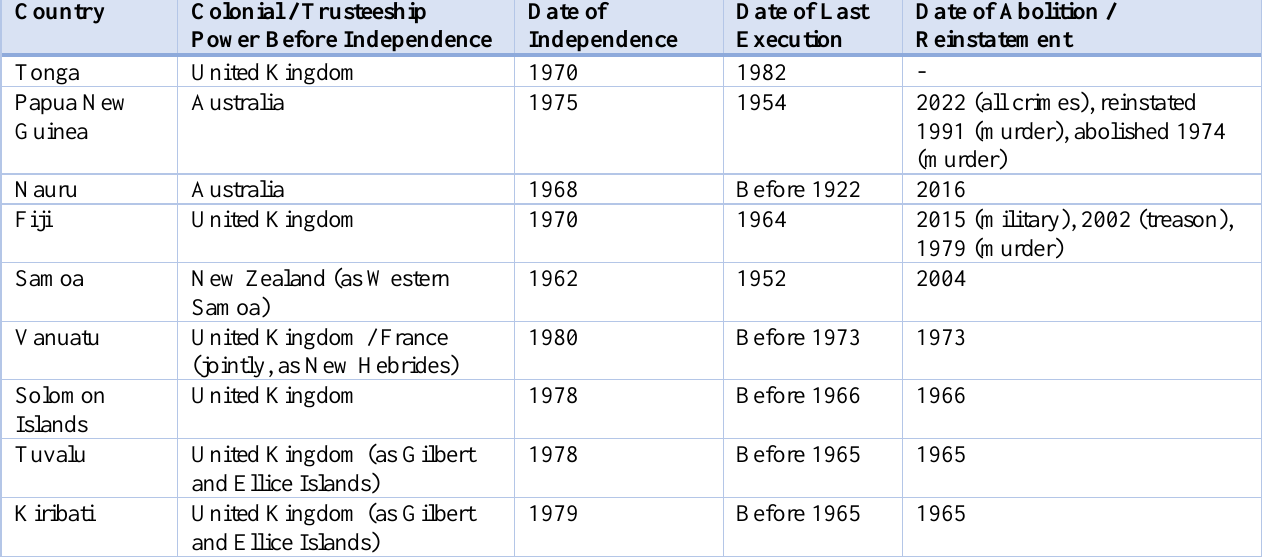
Table 1. Death penalty status in the South